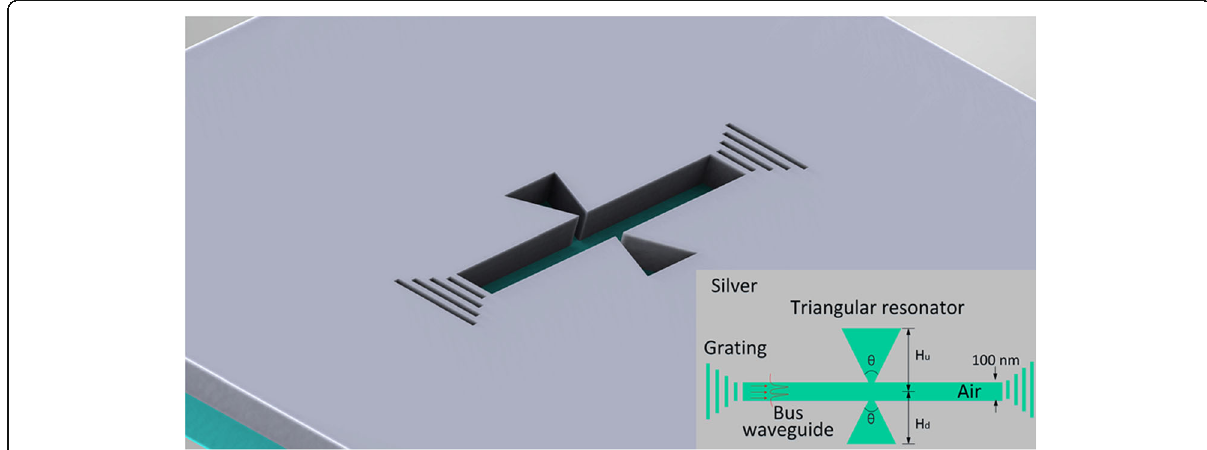
Fig. 1 Schematic diagram of the asymmetric bowtie